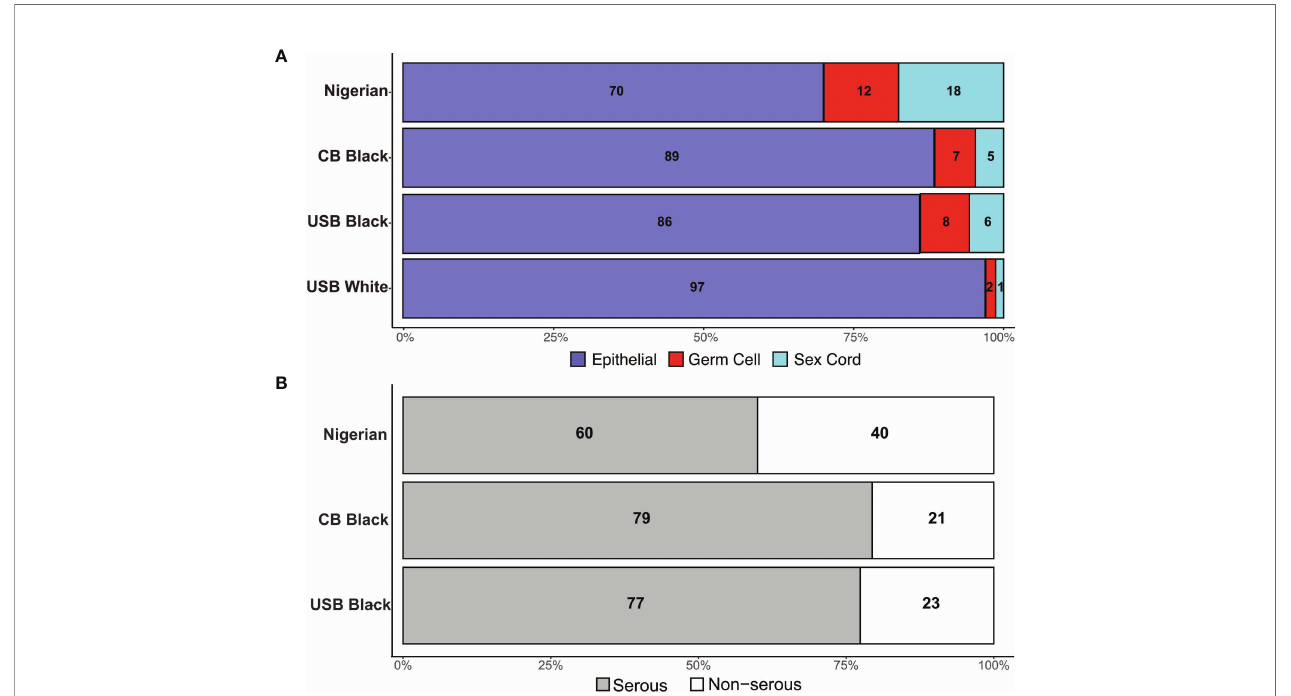
FIGURE 3 | (A) Distribution of tumor histology by cohort. (B) Distribution of Serous tumor types in Black women.